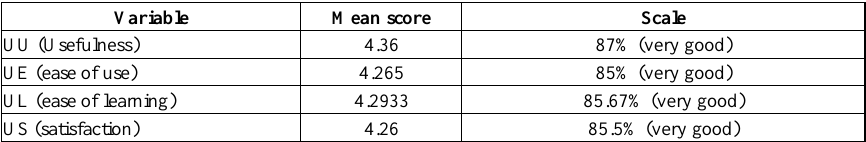
Table 6. The results USE into four